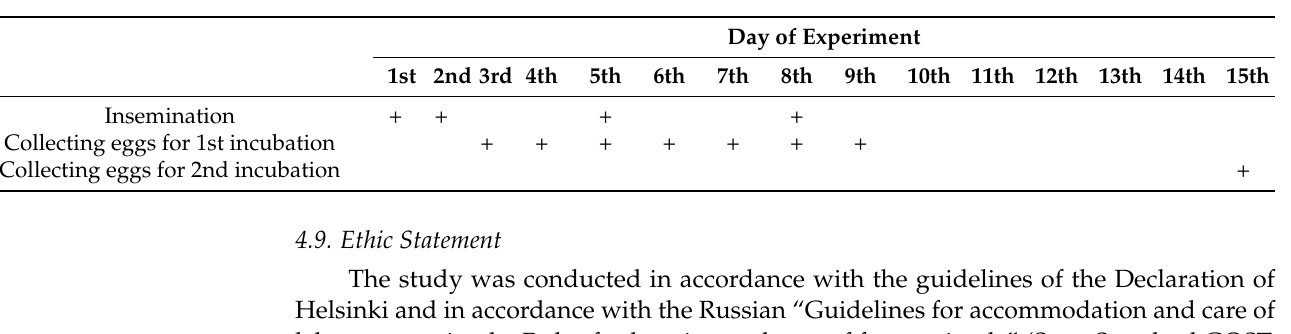
Table 6. Scheme for hen insemination, collection of eggs for incubation, and collection of eggs to assess the survivability of spermatozoa in hens’ genital